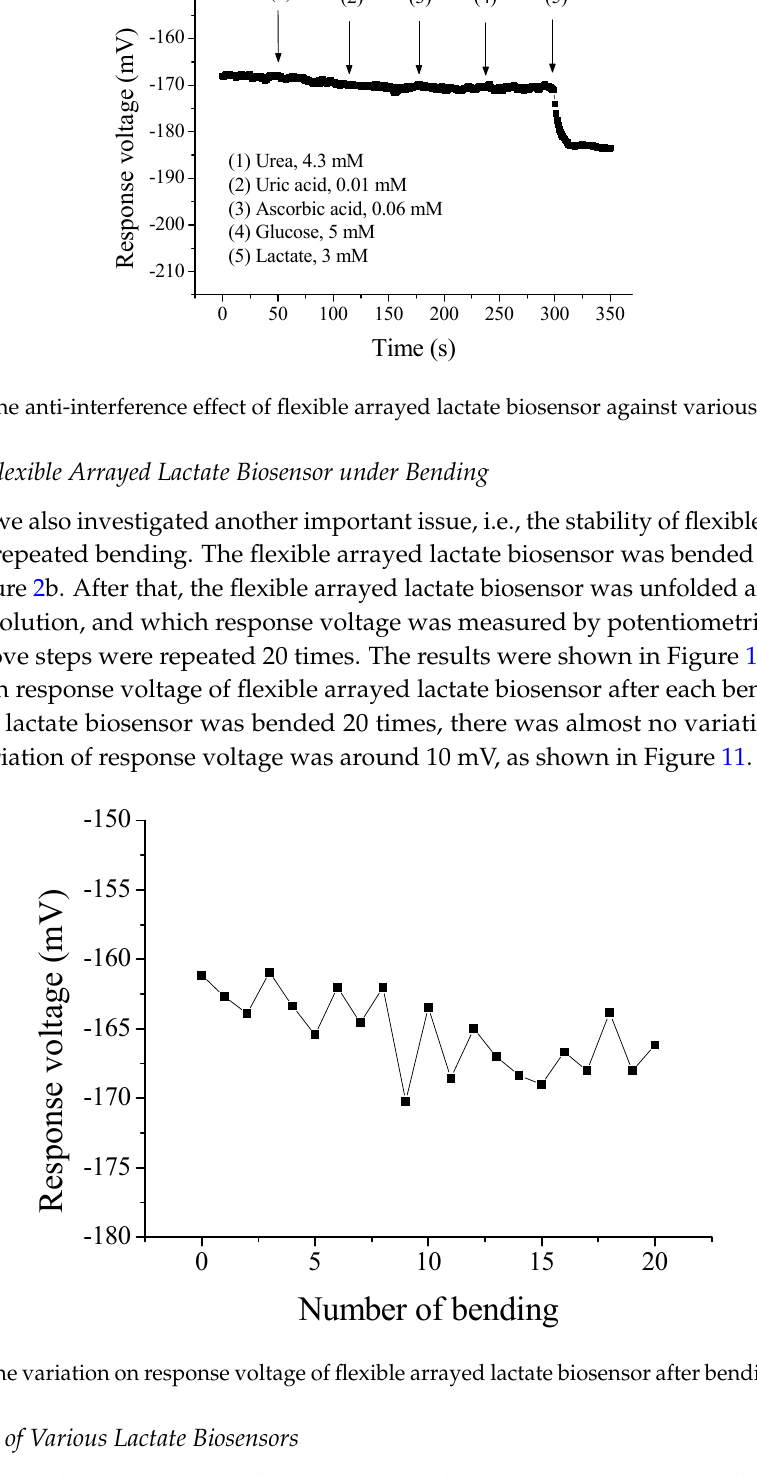
Figure 11. The variation on response voltage of flexible arrayed lactate biosensor after bending 20 times.